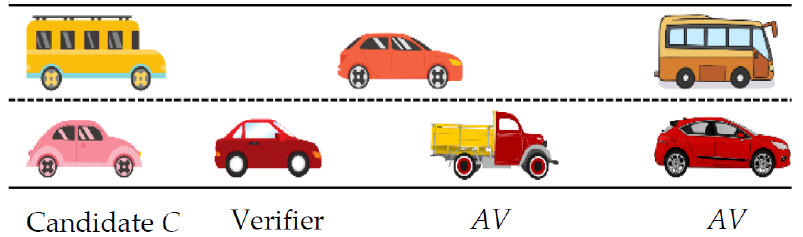
Figure 1. A platoon of three vehicles formed by 𝐴𝑉 1 , 𝐴𝑉 2 , and 𝐴𝑉 3 . Vehicle 𝐴𝑉 3 acts as a verifier V for the candidate C who wishes to be admitted to the platoon. Parties C and V engage in a proof-of- following